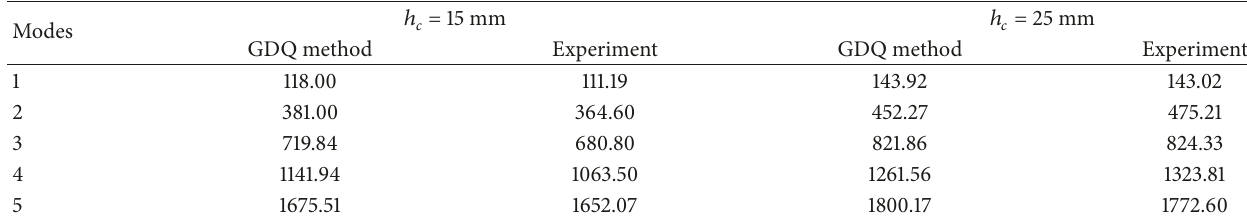
Table 4: The natural frequencies (Hz) for cantilever beam with two different